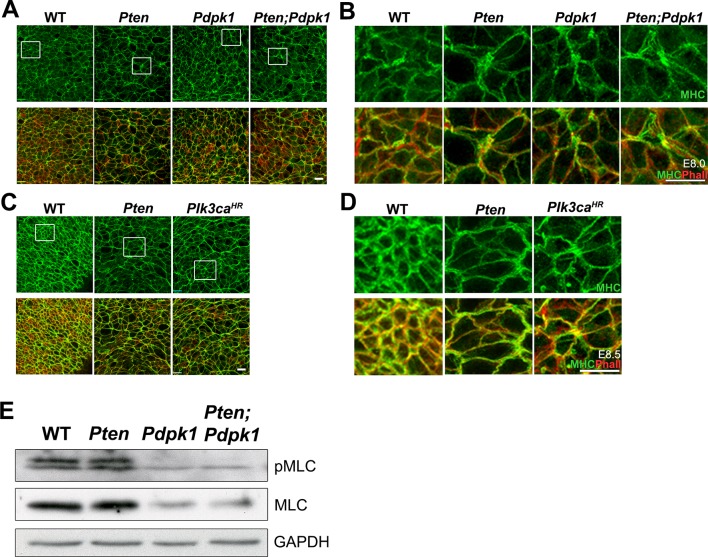
Myosin-II distribution and levels appear normal in the Pten neural plate.(A–D) En face images of the distribution of MHC-IIB (green). (A–B) E8.0 embryos. Myosin was anisotropically distributed in the neural plate of all genotypes (WT, Pten, Pdpk1 and Pten Pdpk1) and no preferential enrichment at long or short cell edges was noted. (C–D) E8.5 embryos. Apical myosin is enriched in all genotypes at E8.5. This is especially prominent in WT, and presumably reflects the formation of the actomyosin rings that mediate apical constriction in the next phase of neural tube closure. Phalloidin is red. Scale bar = 20 μm. (E) Western blot detection of phospho-myosin light chain (pMLC) and total MLC in E8.5 Pten △Epi, Pdpk1 △Epi and Pten △Epi Pdpk1 △Epi embryos. No striking differences between genotypes were apparent.